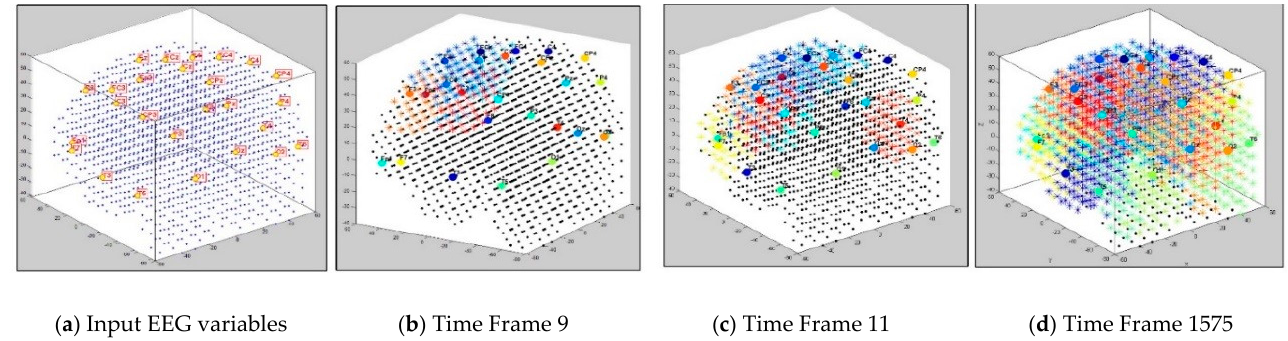
Figure 2. Four steps visualization of dynamic clustering in a BI-SNN model, corresponding to 26 EEG channels (recorded from 21 control subjects) during unsupervised STDP learning. The total number of time frames is 21 samples × 75 EEG time points = 1575 data points.